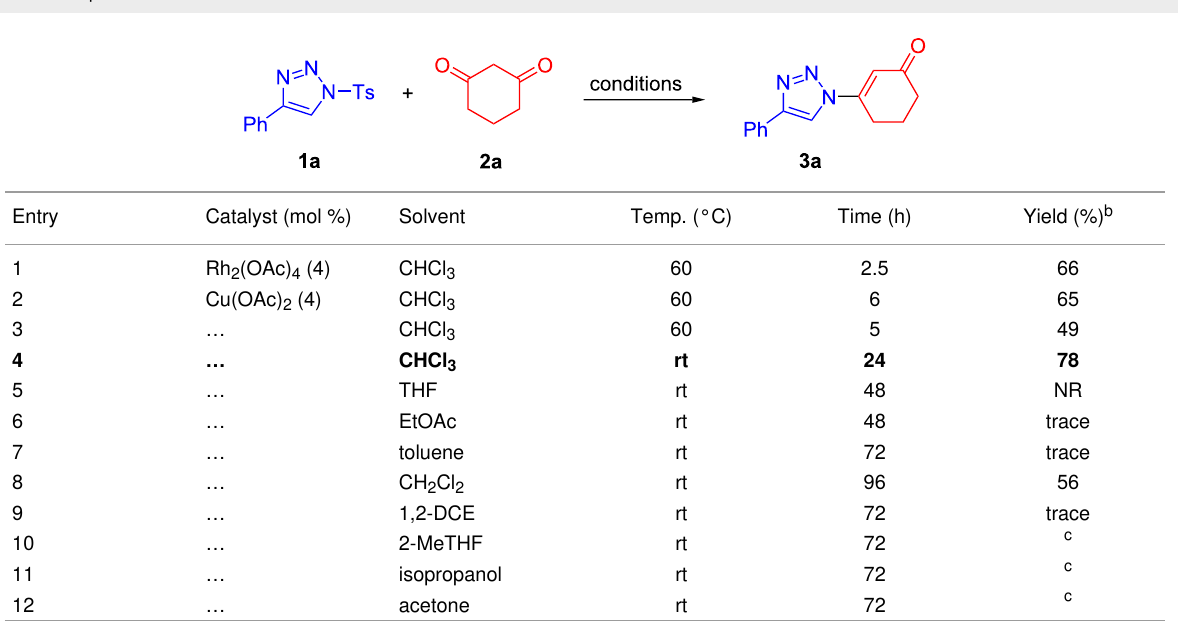
Table 1: Optimization studies.